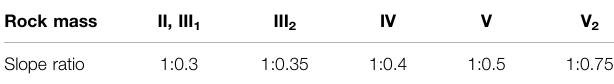
TABLE 1 | Design value of excavation slope